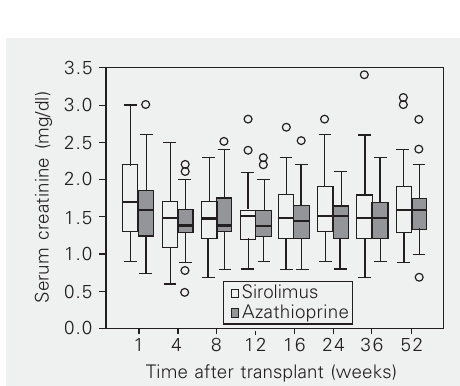
Figure 2. Trough whole blood sirolimus concentrations during the first year after transplanta- tion. Middle horizontal thick bar is the median; the top and bot- tom square lines indicate the 75th and 25th percentiles; the error bars denote the limits of the 90th and 10th percentiles; open circles are outliers. *P = 0.012 (ANOVA, week 1 through week 16).